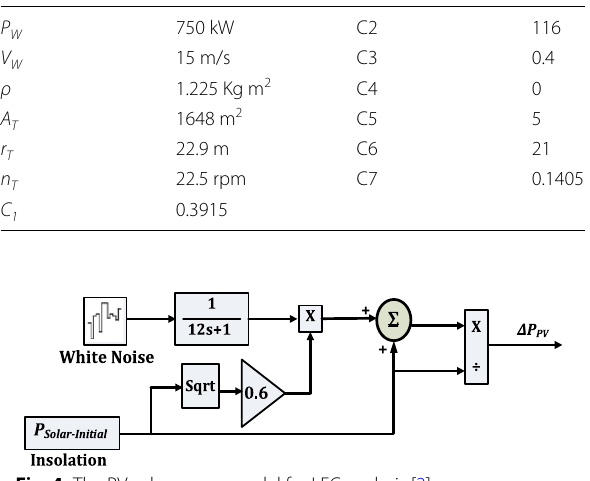
Table 2 Nominal wind turbine parameters Parameter